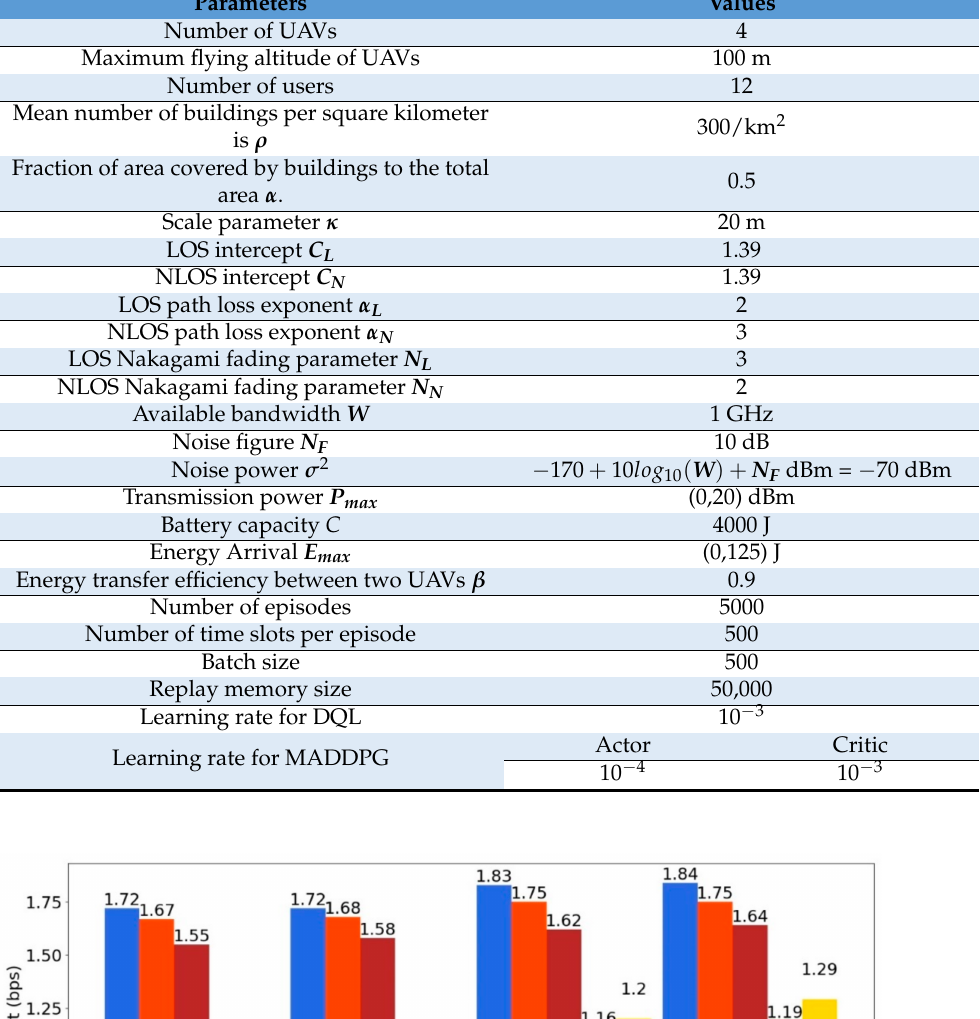
Table 2. Simulation parameters.